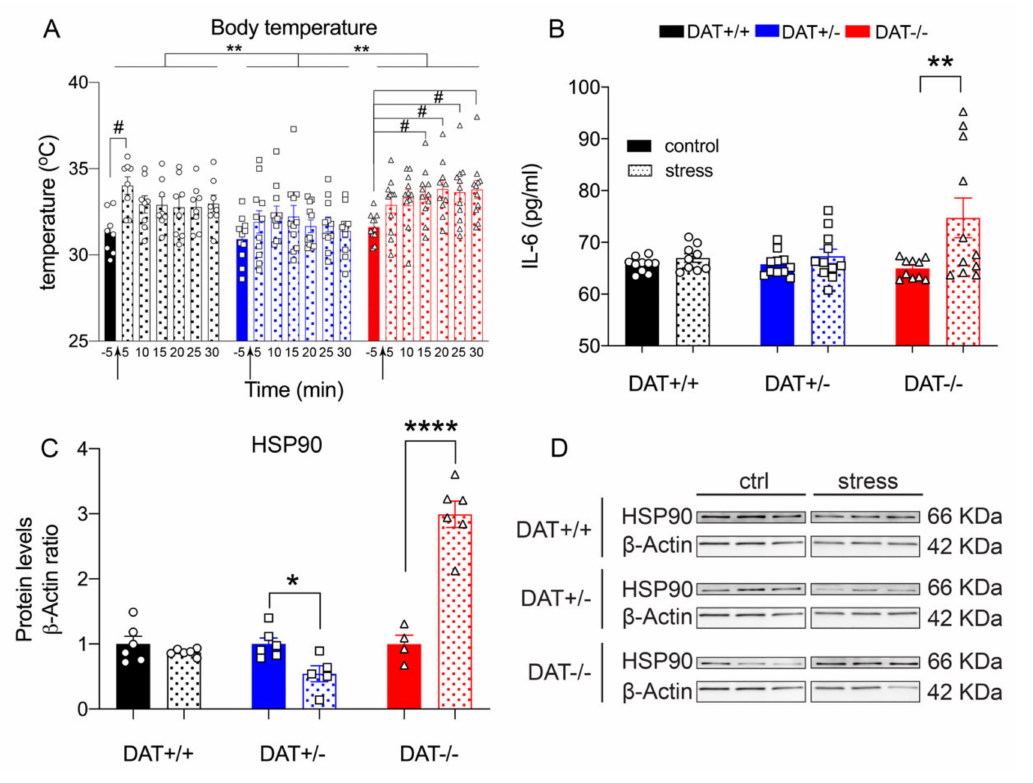
Figure 5. Peripheral and central e ff ects of restraint stress on temperature, IL-6 and HSP90 levels in DAT-KO rats ( A ) Body temperature of DAT +/ - rats is lower than that of DAT +/+ and DAT +/ - rats upon restraint. ( B ) Circulating levels of IL-6 cytokine were increased in DAT- / - rats after restraint stress. ( C ) Restraint stress exposure significantly reduced HSP90 in DAT +/ - rats; however, the stress exposure increased HSP90 protein levels in DAT- / - female rats. ( D ) Immunoblots from representative rats in each group are shown. Data were normalized to β -actin, relative to control (DAT +/+ ). For each genotype, data were relative to basal (non-stress) conditions and normalized to β -actin. Data were expressed as mean ± SEM ( n = 4–6). * p < 0.05; ** p < 0.01 **** p < 0.0001, # p <